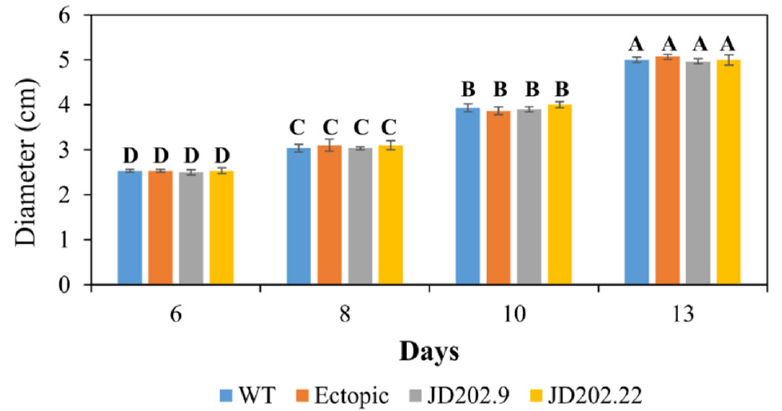
Figure 4. Colony growth of Al Kewell and transformants on 1 / 2 PDA plates. Each bar is the mean of three replicates and error bars are expressed as standard error of the mean. Bars not connected by the same letter are significantly different (Tukey HSD test, p < 0.001).